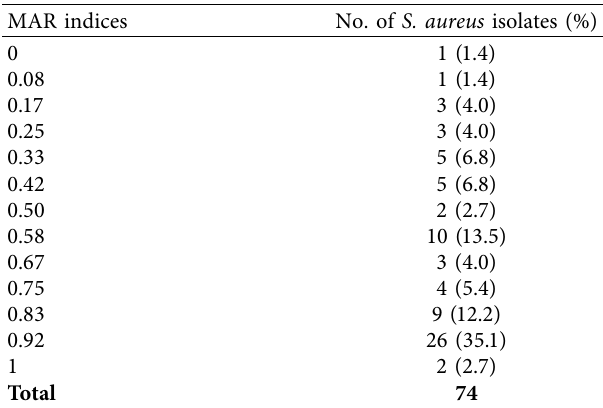
Table 4: Antimicrobial resistance (MAR) index of S. aureus isolates ( n � 74).